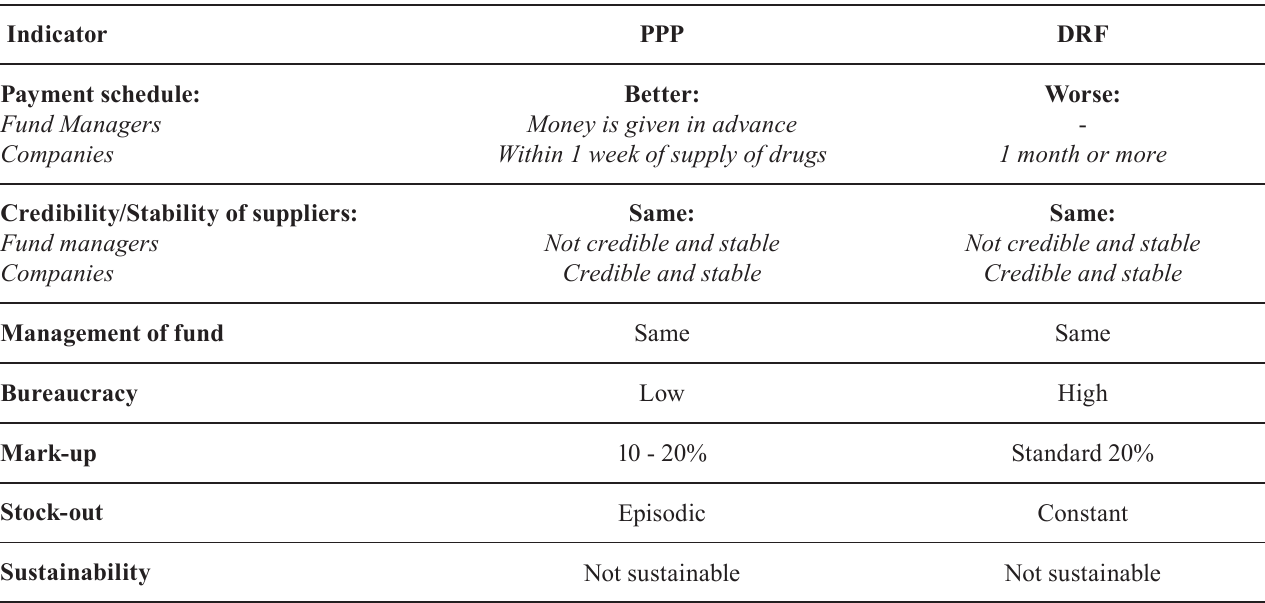
TABLE IV – Comparative analysis of the PPP and DRF models by participants during FGDs